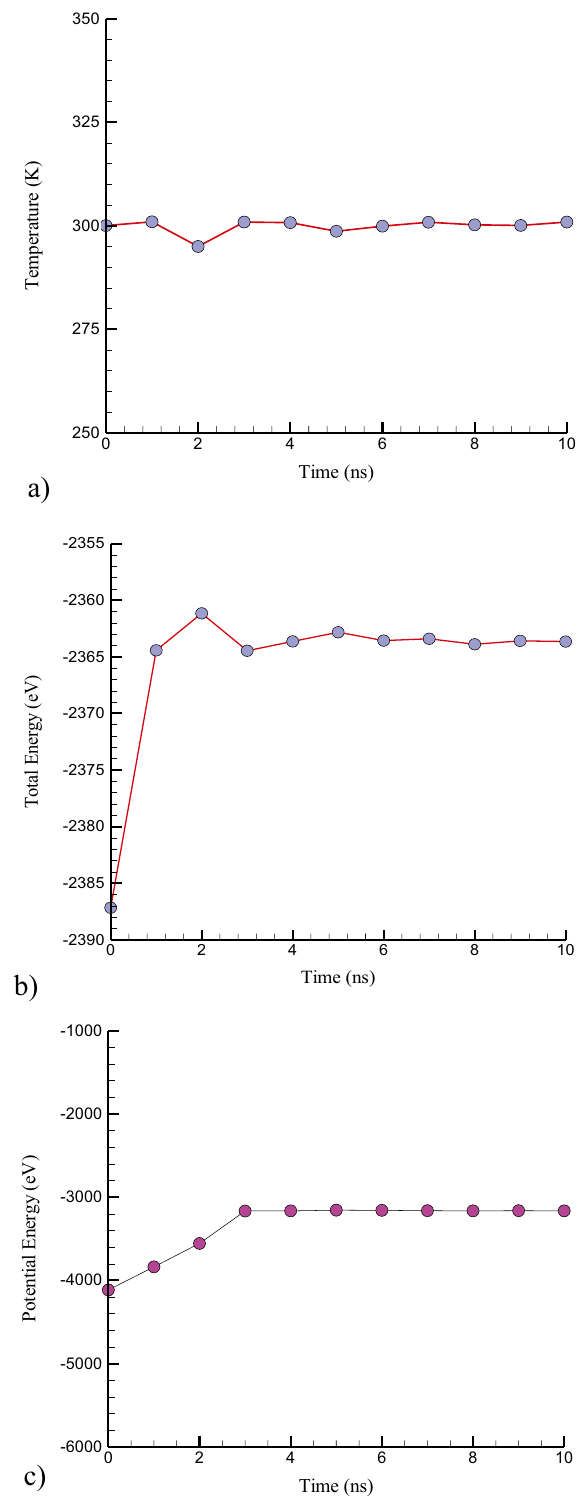
Figure 2. BAG-based nanostructure change’s ( a )temperature, ( b ) total energy, and ( c ) potential energy in terms of MD time at T 0 = 300 K and P 0 = 0